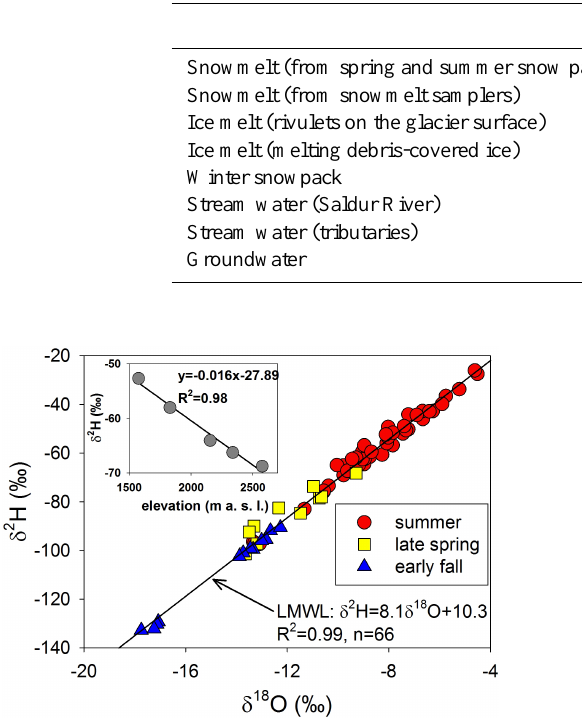
Figure 3. Relationship between δ 18 O and δ 2 H values of rainfall samples. Inset: relationship between elevation and average ( n = 8) δ 2 H in precipitation data from the bulk rainfall collectors. For the inset plot, only data available for all five locations were averaged. Both correlations are statistically significant at the 0.01 level.